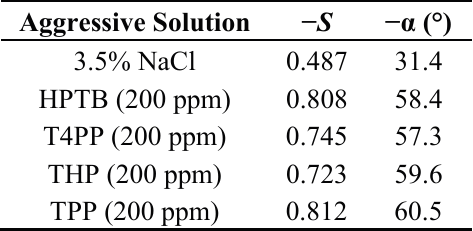
Table 2. The slopes of the Bode modulus plots at intermediate frequencies ( S ) and the maximum phase angles ( α ) of the Bode phase angle plots for N80 steel in 3.5% NaCl solution saturated with CO 2 in absence and presence of